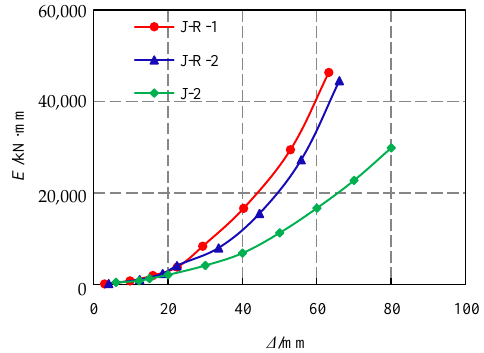
Figure 15. Cumulative hysteretic energy consumption of the specimens.